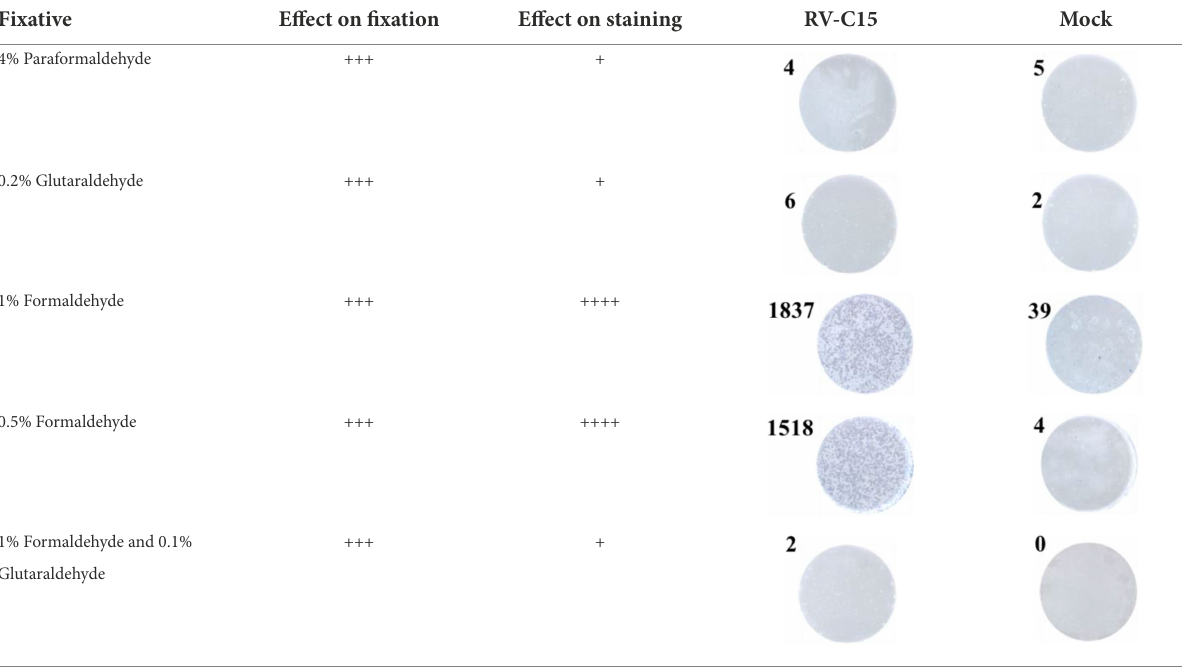
TABLE 3 Effect of different fixatives on fixation and staining.